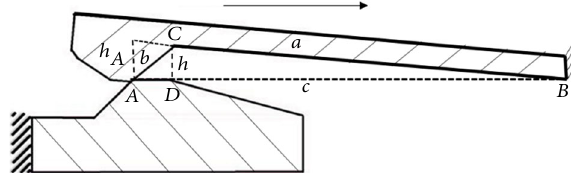
Φ θ relationship. 1 , and Z ,